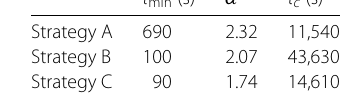
Table 1 Overview of MLE values for the 3 different strategies. Shown are the MLEs for the truncated power law, which provided the best model for the data, according to model selection based on Akaike weights t min (s) α t c (s) Strategy A 690 2.32 11,540 Strategy B 100 2.07 43,630 Strategy C 90 1.74